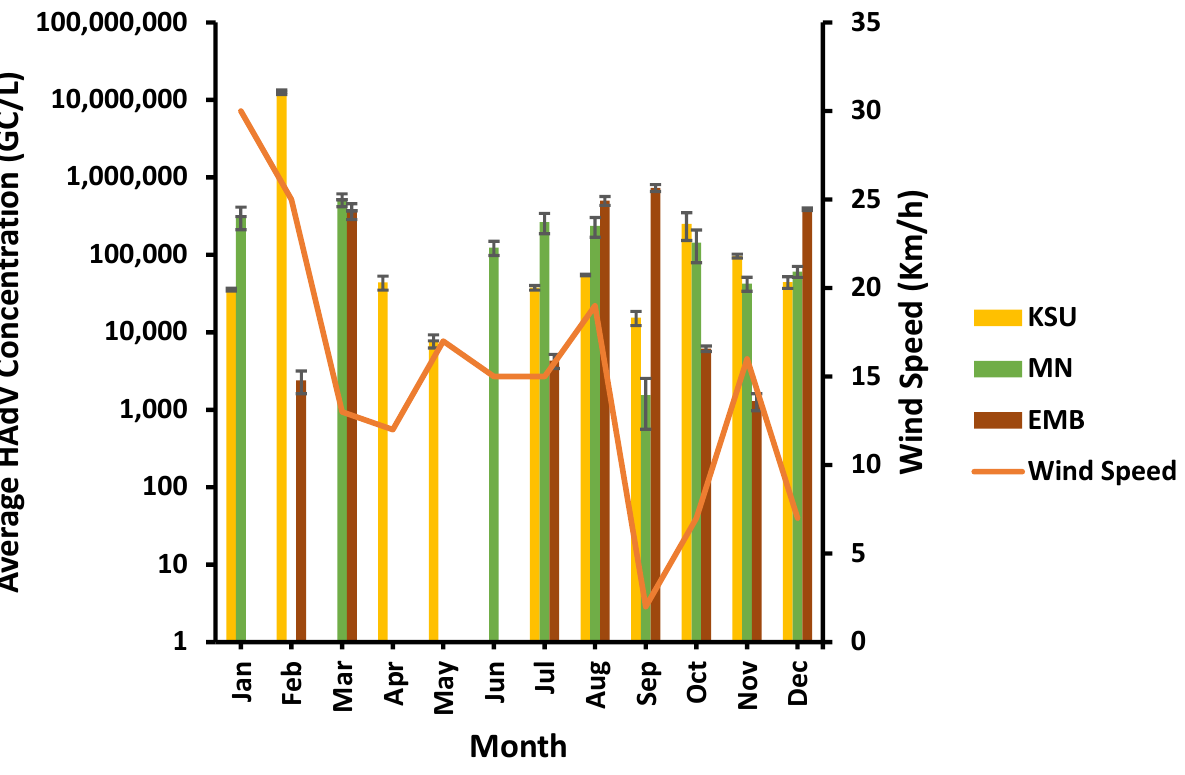
Figure 10. Influence of wind speed on HAdV concentration.